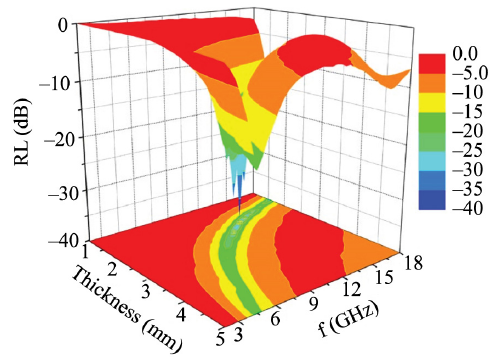
Figure 4. 3D representation of the RL derived from the measured and of the Ni-paraffin composites as a function of the